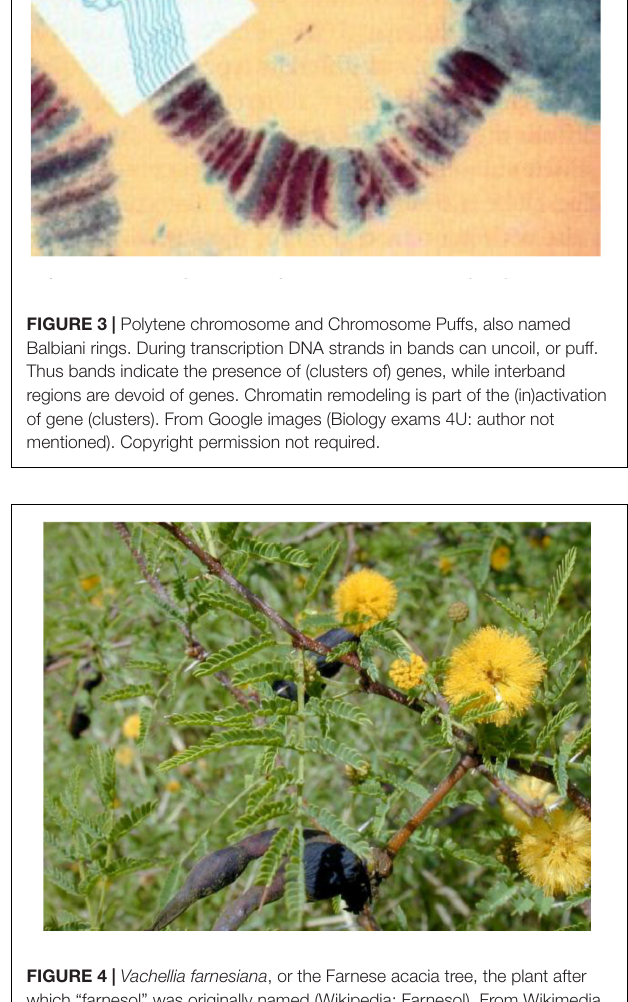
FIGURE 4 | Vachellia farnesiana , or the Farnese acacia tree, the plant after which “farnesol” was originally named (Wikipedia: Farnesol). From